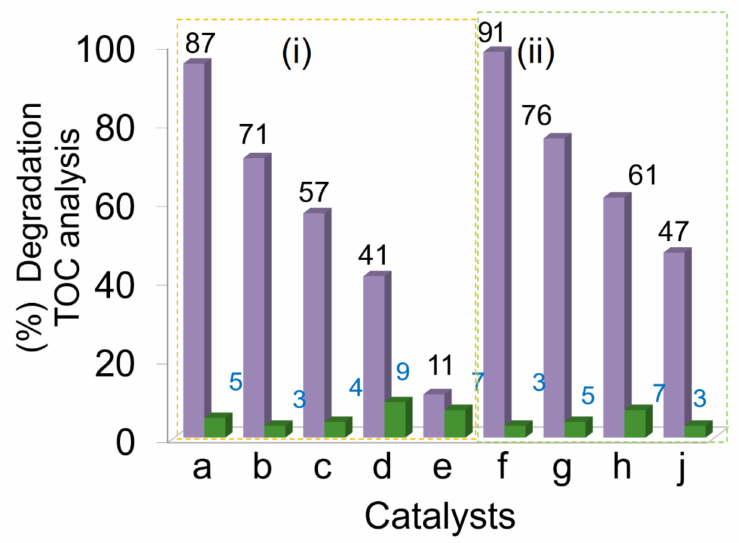
Figure 7. Photocatalytic performance evaluated by TOC measurements for ( i ) 4-NPh removal, after 360 min of irradiation, shown as: (a) Ag_MgGaAl; (b) Au_MgGaAl; (c)